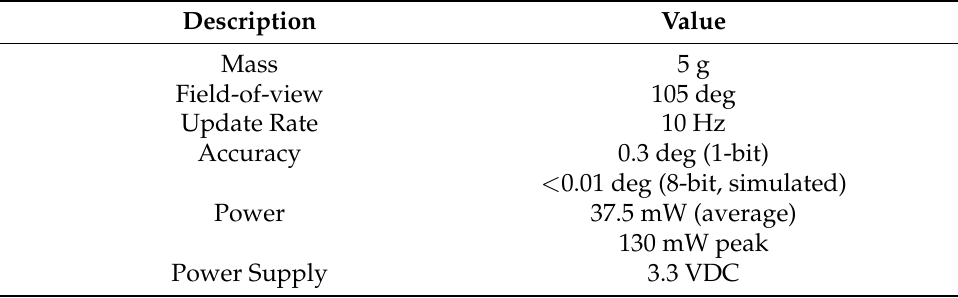
Figure 1. Proposed single-slit digital sun sensor design. Left: installed MLX75306 photodiode, Right: mask design technical drawing. Table 1. Digital sun sensor